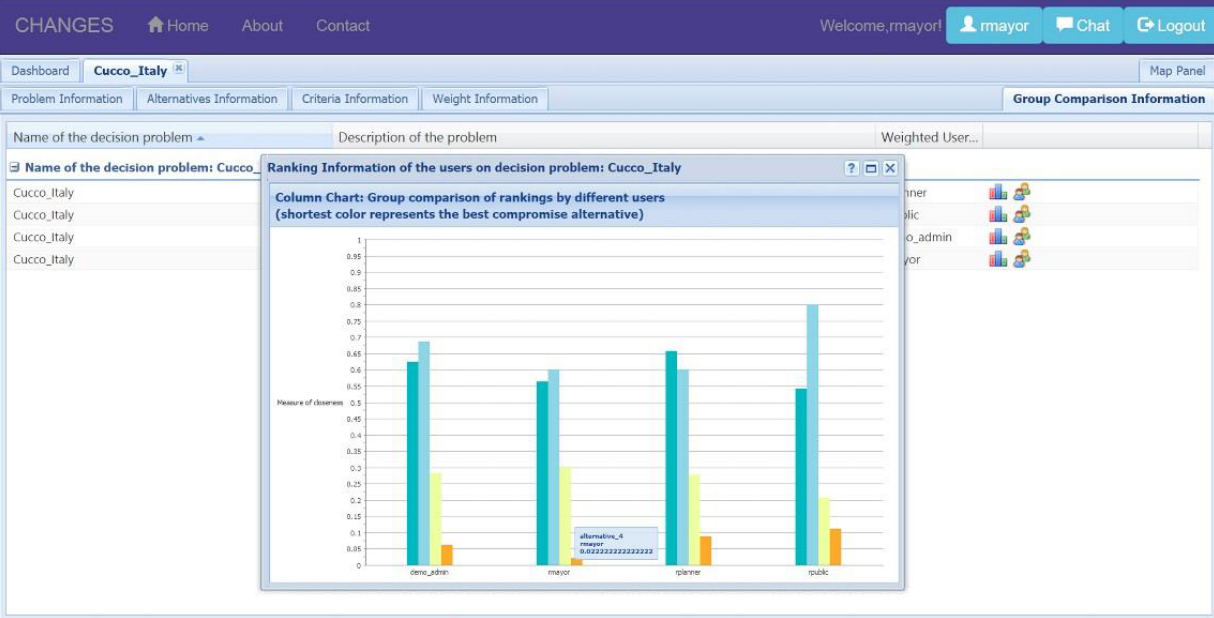
Figure 15. Visualization of ranking results for weights assigned by the user.